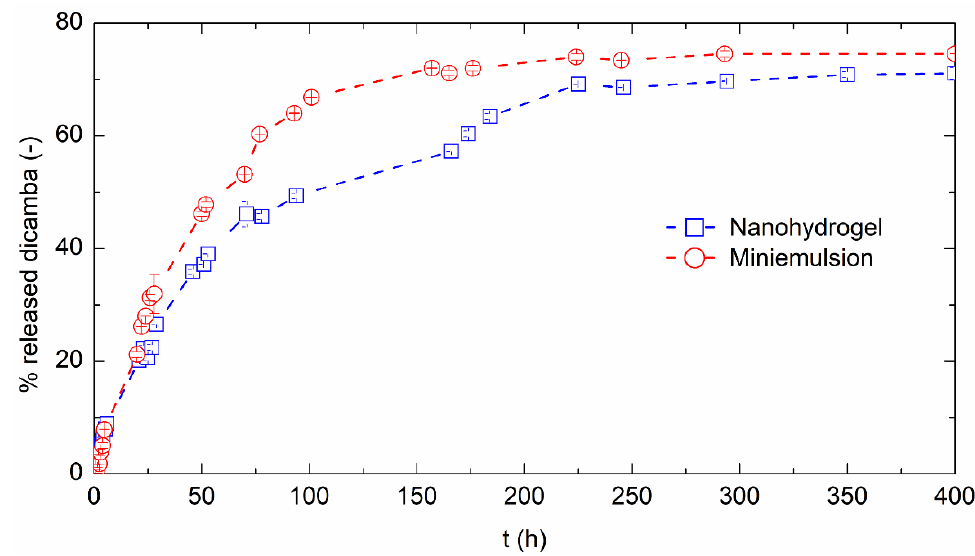
Figure 4. Cumulative percentage of non-encapsulated and encapsulated released dicamba. The percentage was calculated taking the dicamba mass loaded in the miniemulsion/nanohydrogels as a